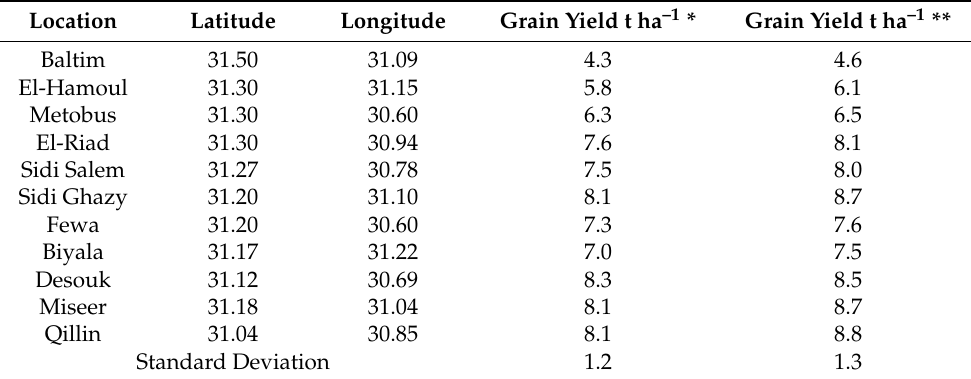
Table 5. Predicting wheat yield for different locations in the studied locations using the calibrated AQUACROP and APSIM models under better